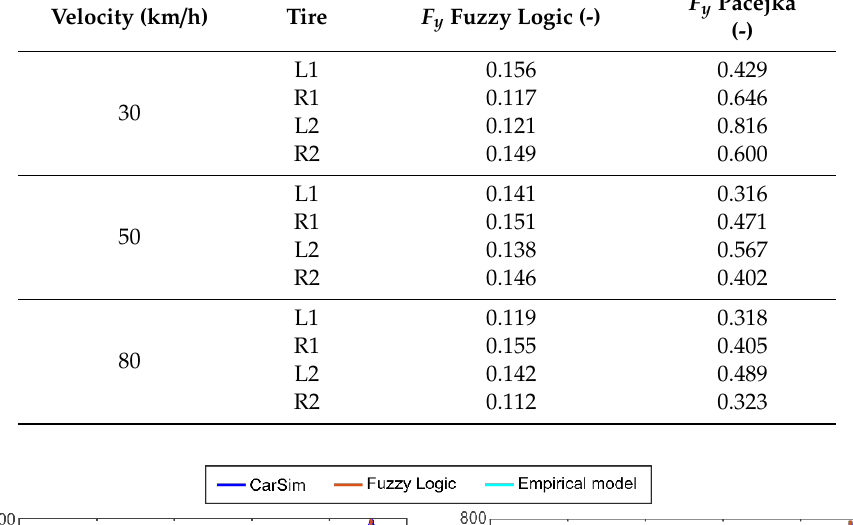
Table 2. Parameters for empirical model of lateral force fitting and goodness of fit.